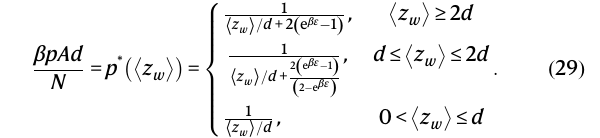
equation of state of a bulk ideal gas for ε =0,i : e : , p = k B TN A z w Figure 3 gives an illustration for T =0 : 9525 ∣ ε ∣ k B (cid:1) 1 ð e βε =0 : 35 Þ . The two discontinuous jumps of pore width at p c 1 and p c 2 correspond precisely to the discontinuous derivative of Gibbs free energy at the two crossing points in Fig. 2, which are cusps. It is very interesting to note that drawing a horizontal line corresponding to p c 1 (or to p c 2 ) in Fig. 3 (yellowdashedlines)providesakindofMaxwellconstruction.Itcanbe shown analytically that the turquoise and pink zones have the equal